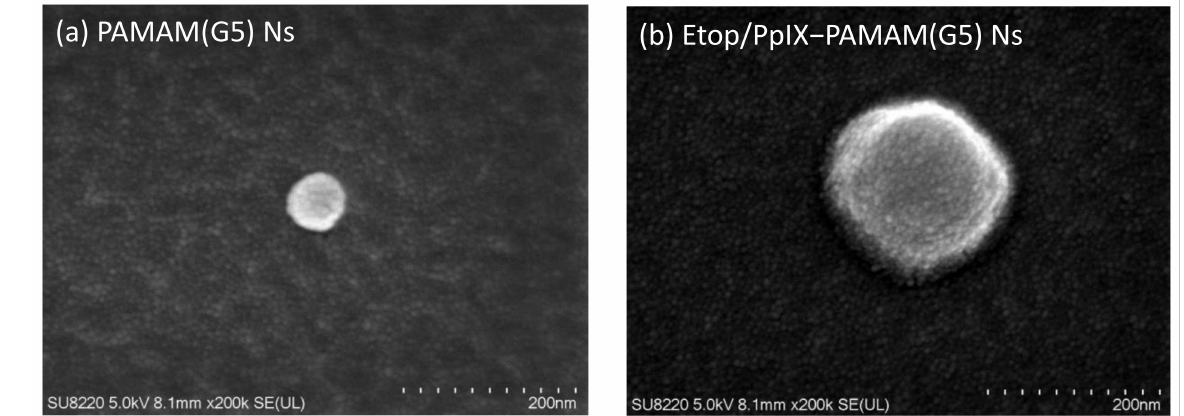
Figure 1. ( a ) FE-SEM image of PAMAM(G5) Ns; ( b ) Etop/PpIX-PAMAM(G5) Ns at 200,000 × magnification. (Etop—etoposide, FE-SEM—field emission scanning electron microscope, PAMAM(G5) Ns—generation-5 polyamidoamine dendrimer nanosphere, PpIX—protoporphyrin IX).